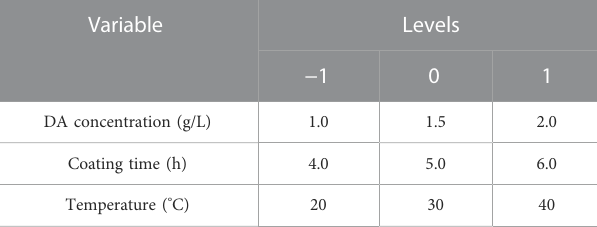
TABLE 1 Response surface optimization experimental factor-level table. Variable